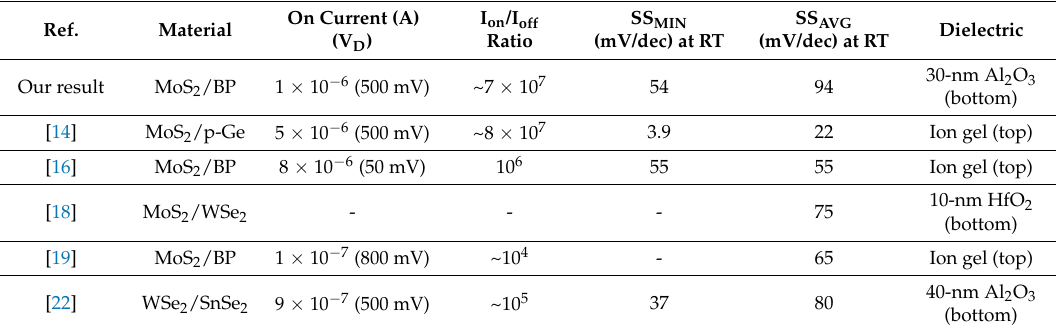
Table 1. Comparison of the performance of the 2D/2D tunneling FETs reported in the literature.